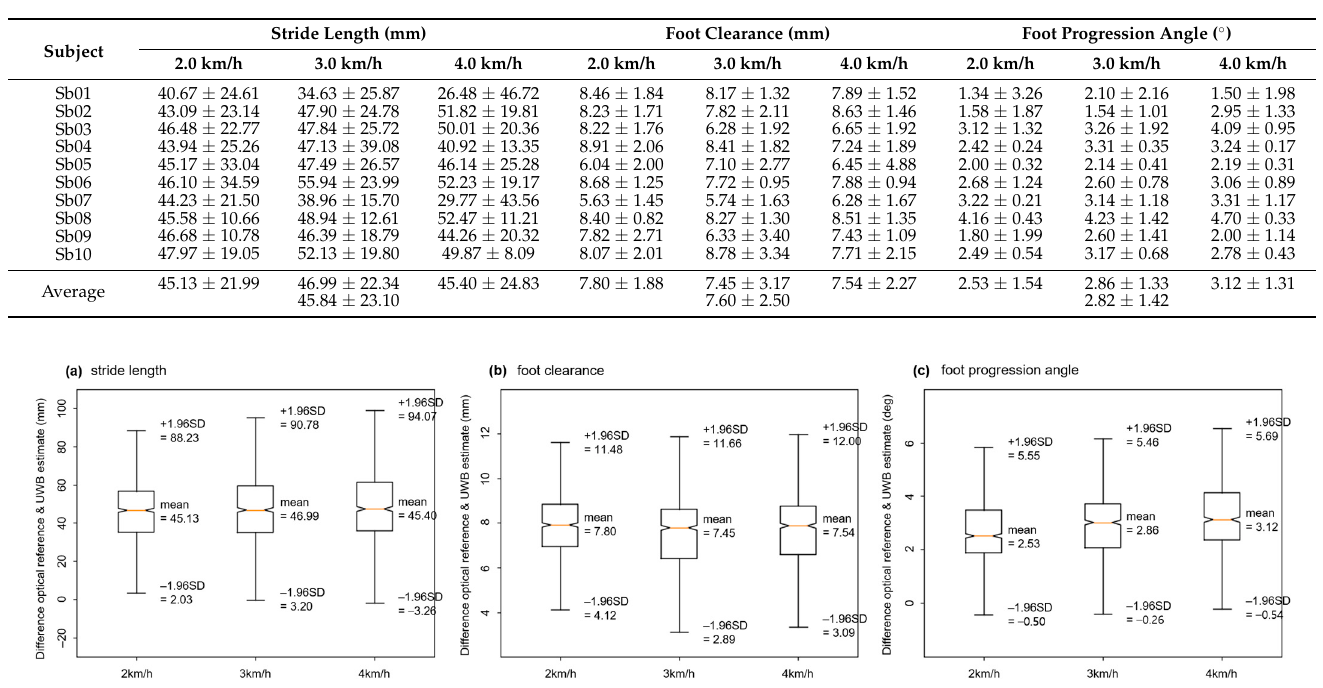
Figure 8. Box plot results for difference between motion capture and UWB approach: ( a ) Difference in stride length; ( b ) Difference in foot clearance; ( c ) Difference in foot progression angle test-results. The estimated gait parameters from UWB and MCS were compared: they show good correlation coefficients (r 2 > 0.7) of 0.898 in SL, 0.761 in CL, and 0.743 in FPA.